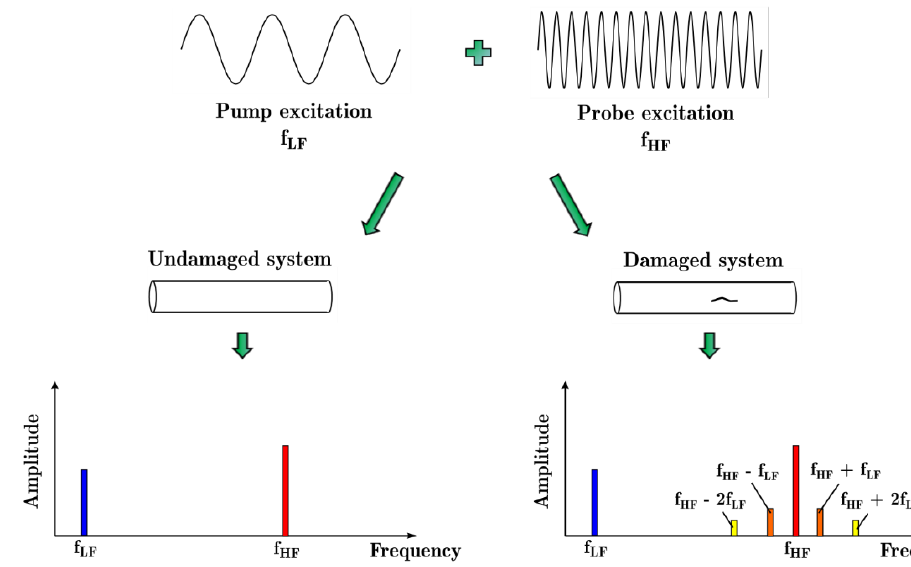
Figure 1. Schematic representation of the nonlinear vibro-acoustic modulation (VAM) technique.